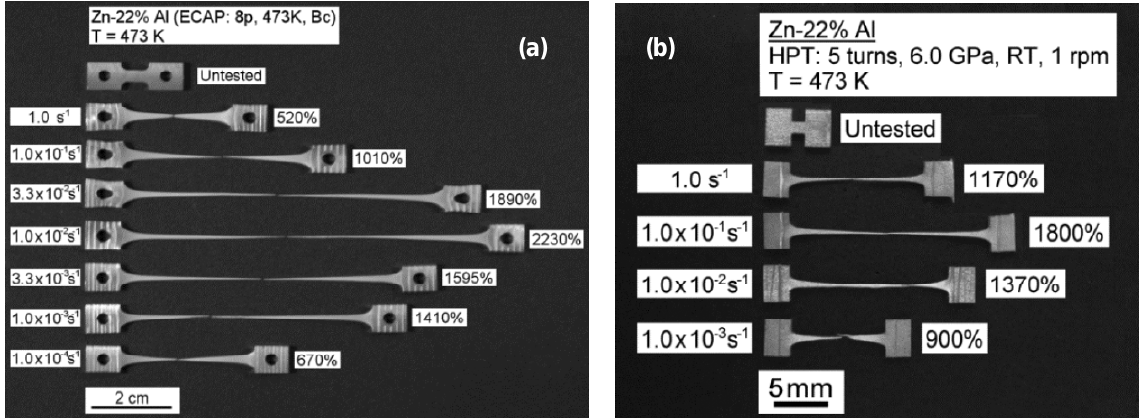
Fig. 3. Superplastic flow at different strain rates at 47K in a Zn-22% Al alloy after processing by (a) ECAP [17] and (b) HPT